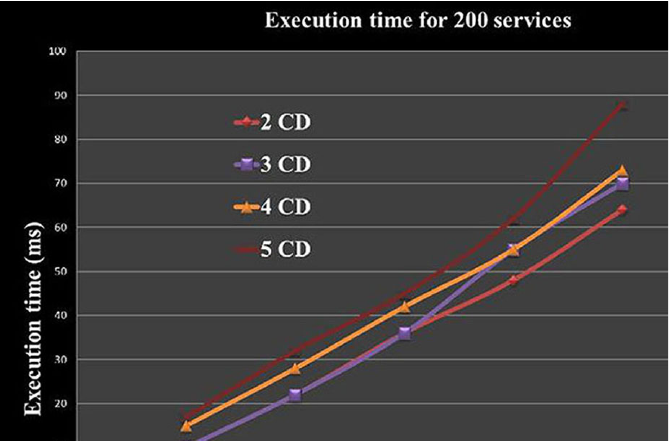
Fig. 8. Execution time by varying the number of context